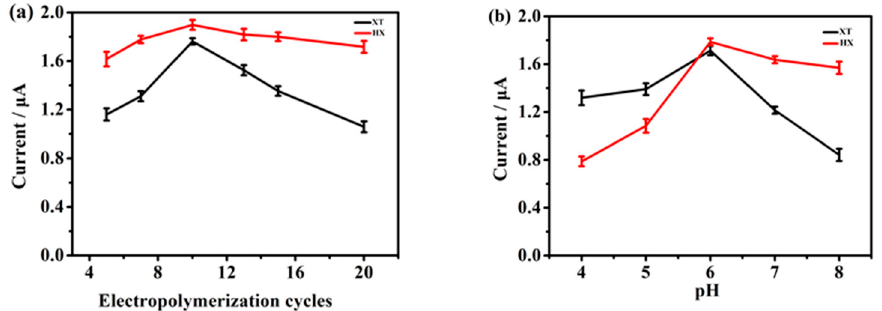
Figure 5. Effects of ( a ) the electropolymerization cycles and ( b ) pH values for the oxidation on p- Gly/rGO/GCE with the addition of 40 μ M XT and 40 μ M